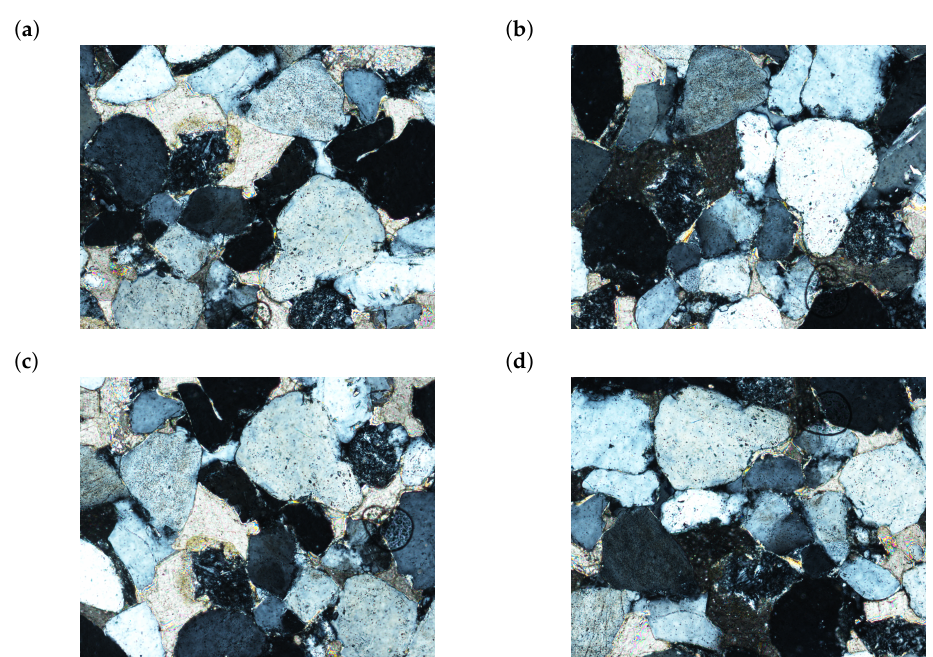
Figure 4. Part of the original set of images: ( a ) Angle 0°, ( b ) Angle 40°, ( c ) Angle 90°, ( d ) Angle 140°.